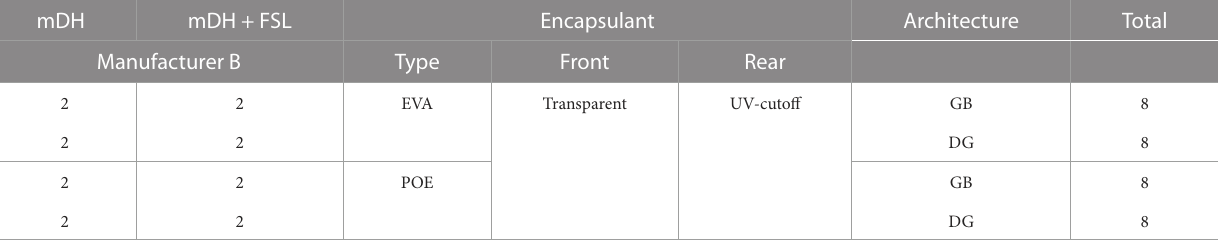
TABLE1 Quantityandspecifications(encapsulanttypeandmodulearchitecture)ofminimodulesbymanufacturerBinexposureconditions.